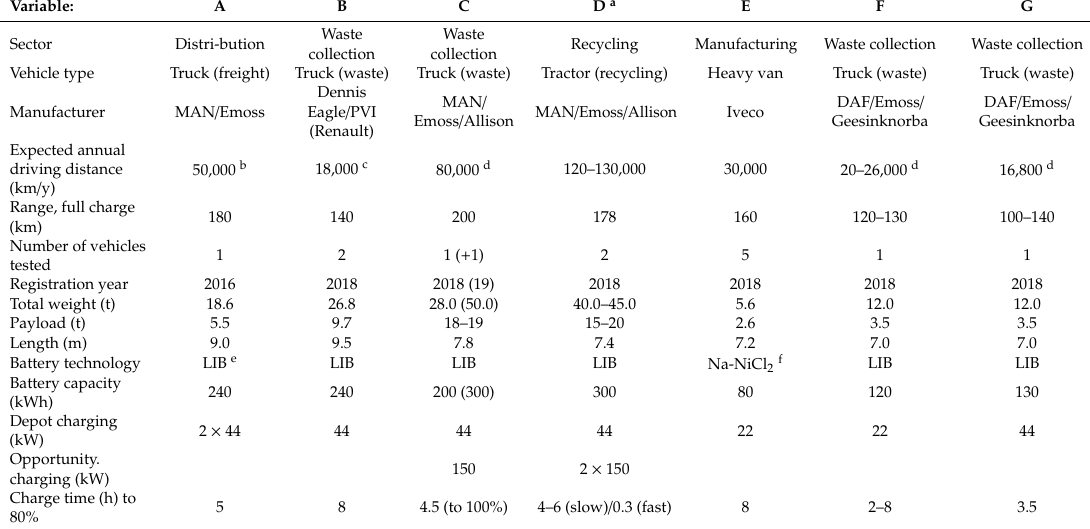
Table 2. Electric heavy-duty vehicle trials beginning 2017 / 2018 in Norway, upon which interviews were based. Source: Autosys [17] and interviews with the operators. a At the time of the interview, the operator only had experience from a test-vehicle. b Average fleet value. c Actual km / y driven at time of interview. d For a similar (existing) ICE fleet. e LIB = Lithium ion. f NaNiCl 2 = Sodium nickel chloride.